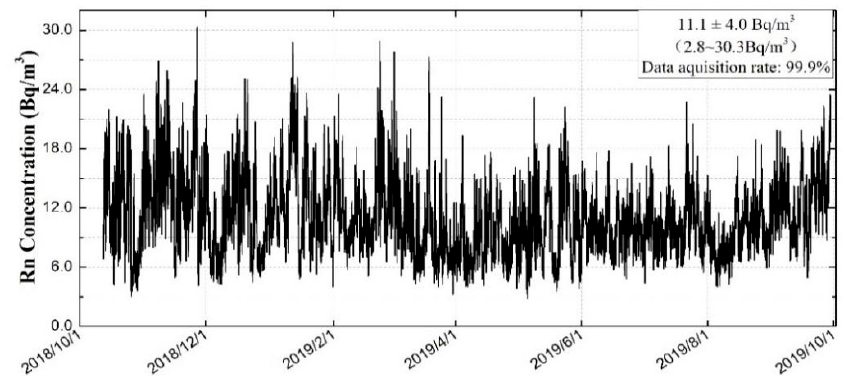
Figure 7. Hourly measurement result of atmospheric radon concentration in